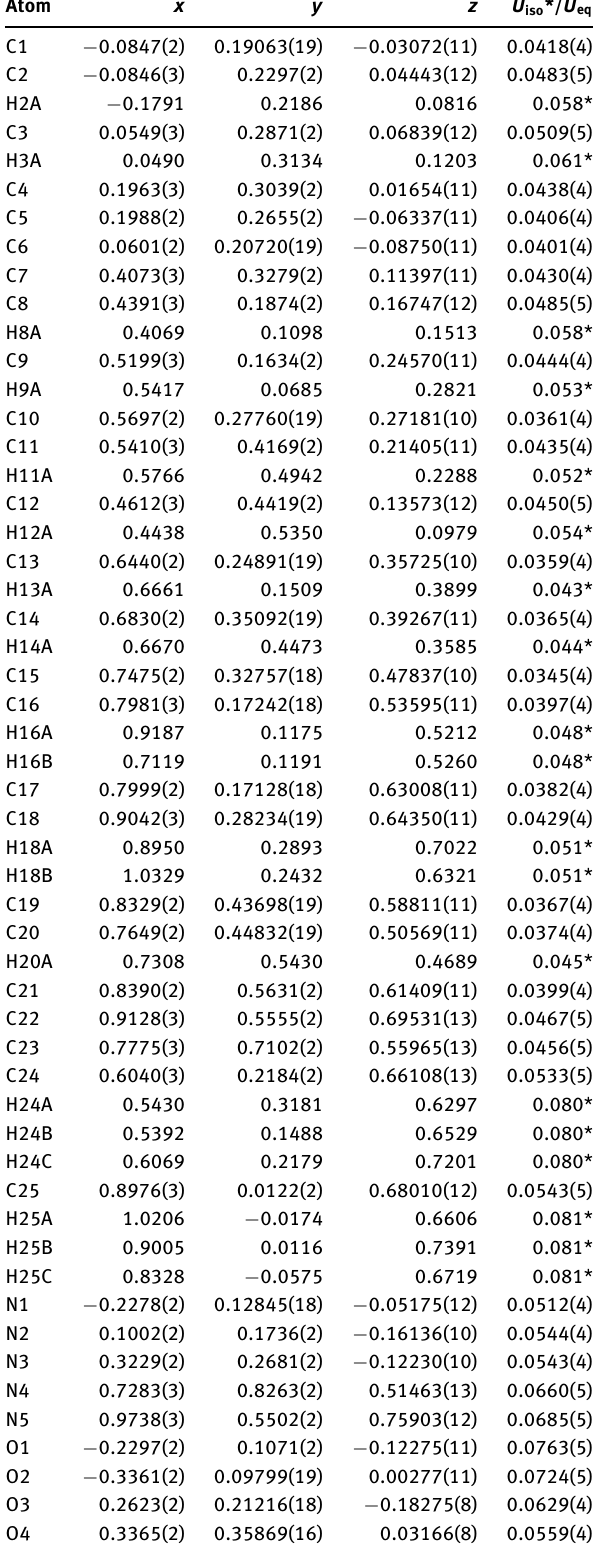
Table 2: Fractional atomic coordinates and isotropic or equivalent isotropic displacement parameters (Å 2